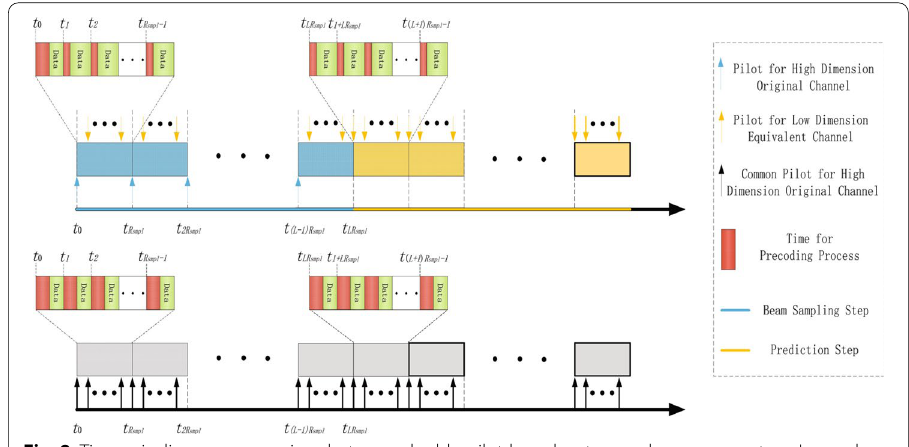
Fig. 8 Time axis diagram comparison between double-pilot-based system and common system. Legend: pilot for high-dimension original channel. Pilot for low-dimension equivalent channel. Common pilot for high-dimension original channel. Time for precoding process. Beam sampling step. Prediction